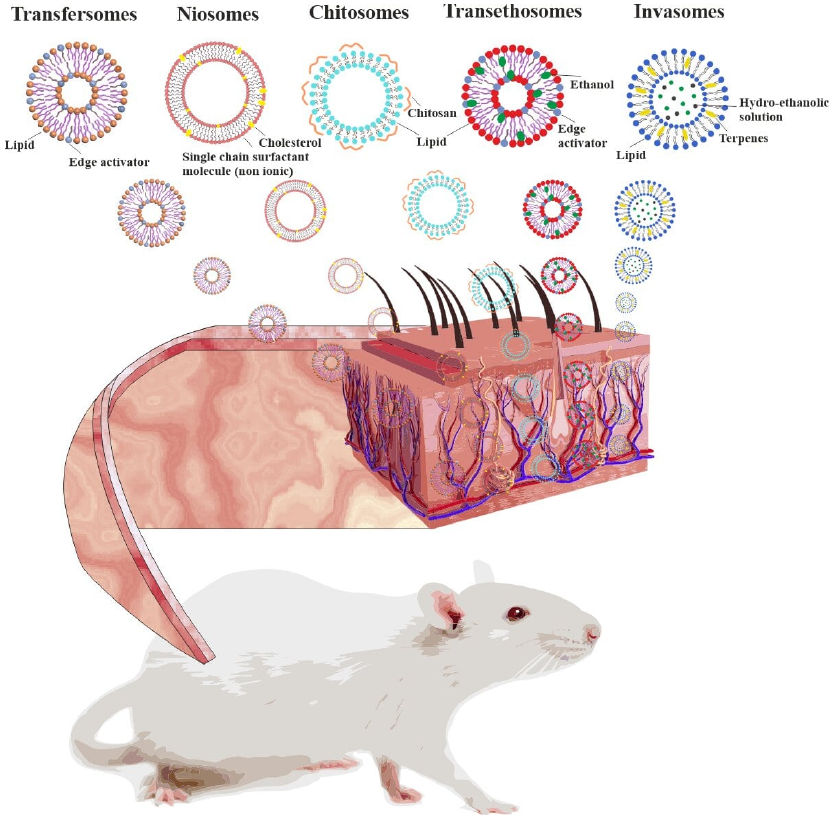
Figure 7. Different types of lipid-based nanocarriers used in transdermal drug delivery.